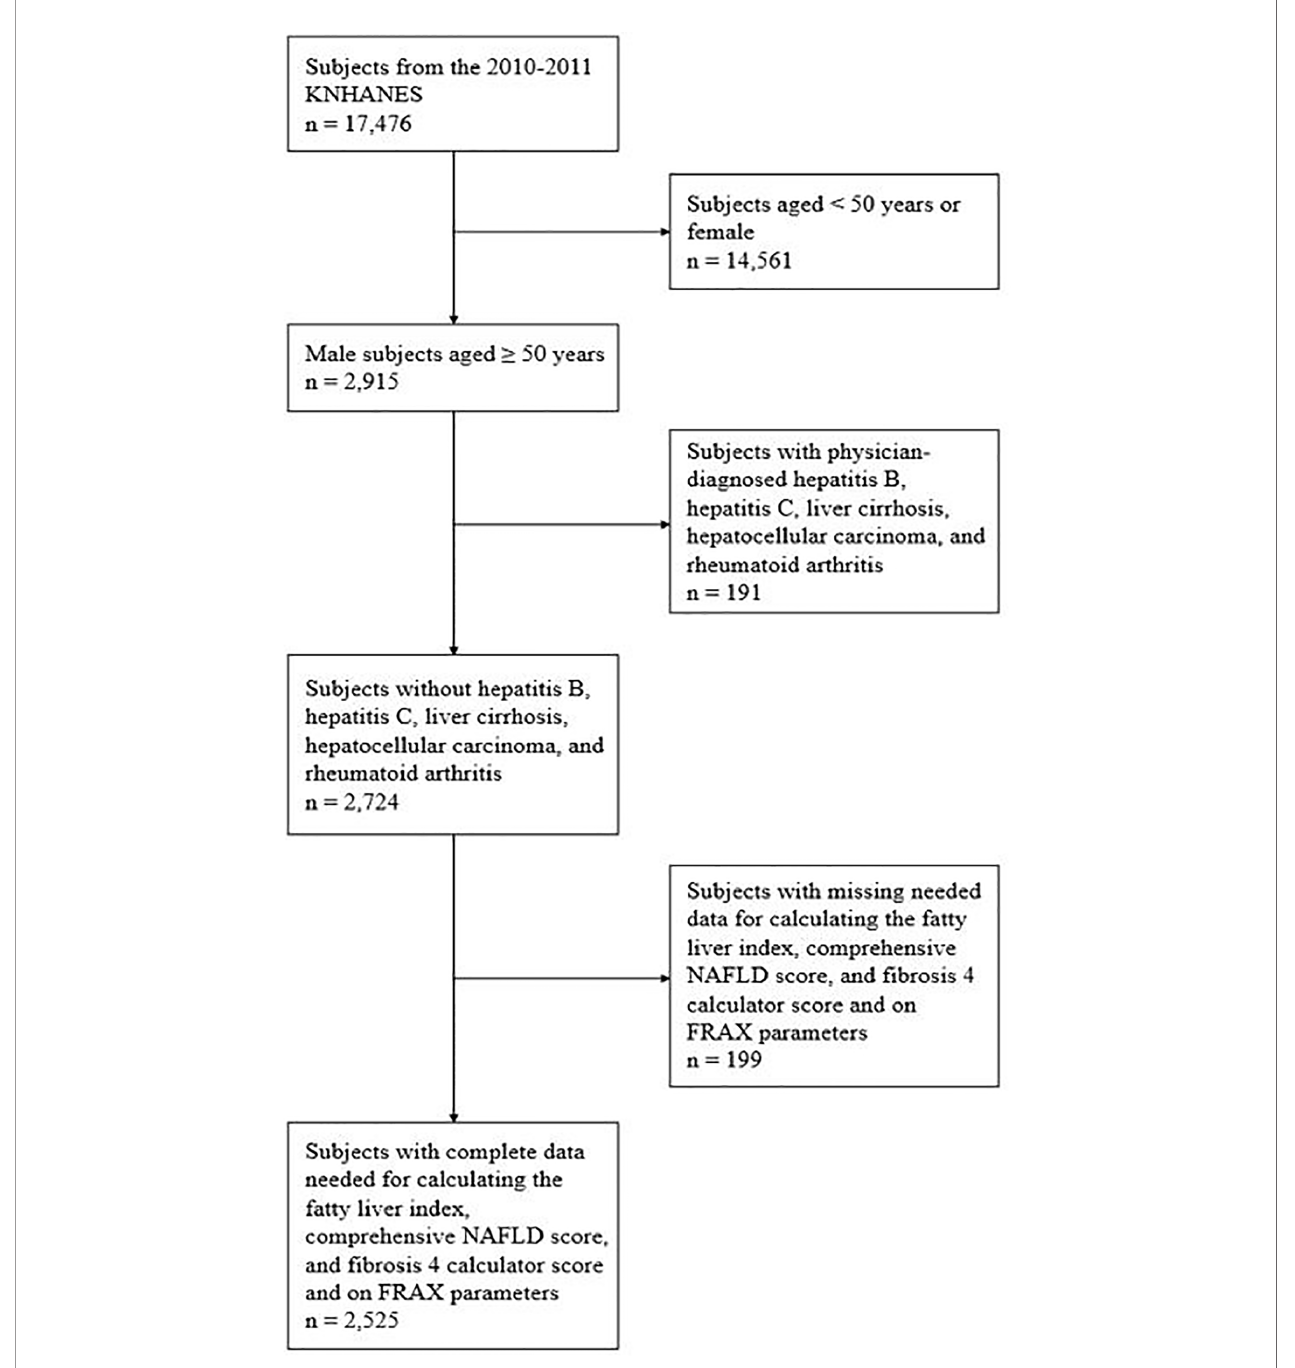
FIGURE 1 | Subject inclusion fl ow chart. KNHANES, Korea National Health and Nutrition Examination Survey; NAFLD, nonalcoholic fatty liver disease; FRAX, fracture risk